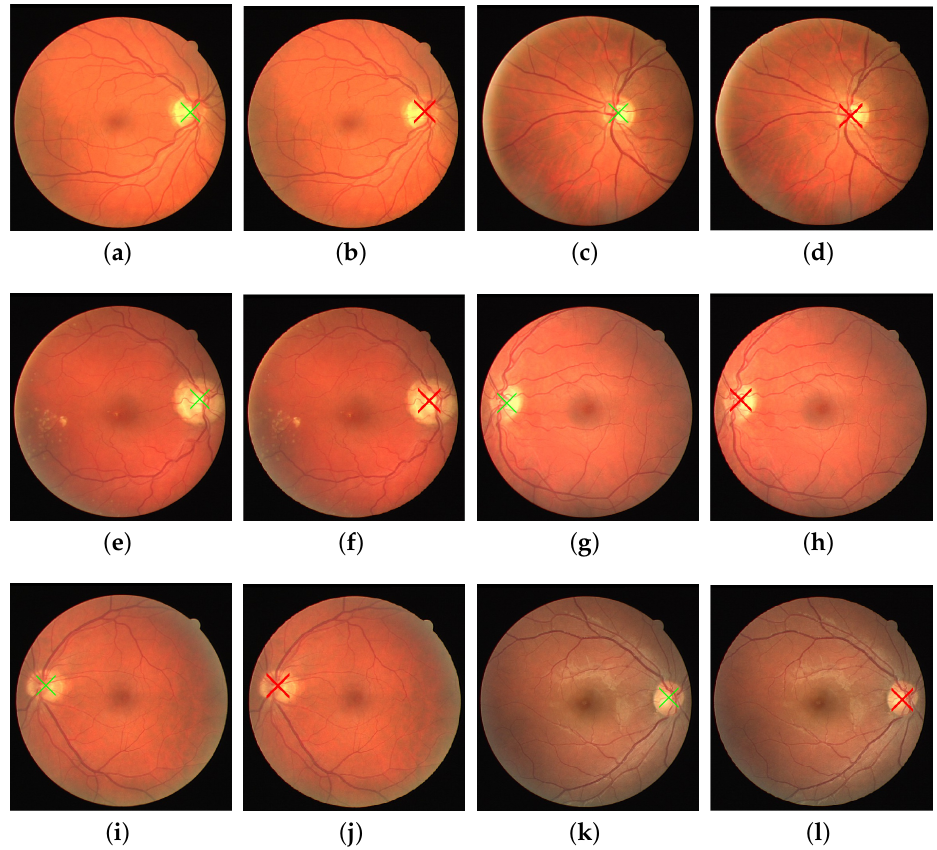
Figure 3. Results of the proposed method (the red cross represents the estimated OD center). ( a , c , e , g , i , k ) The OD center annotation ground truth. ( b , d , f , h , j , l ) Results of the proposed method on the DRIVE